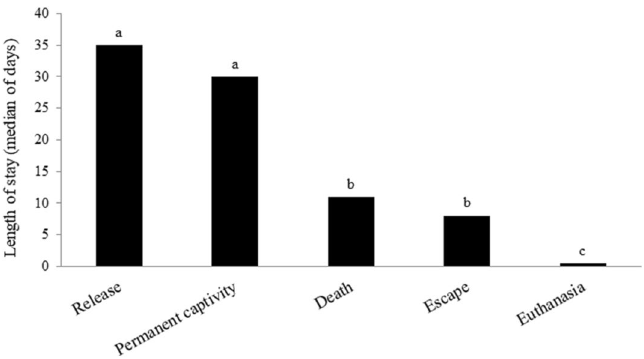
Figure 2. Comparison of the length of stay of common kestrels in rehabilitation centres depending on the outcome. a-c The values in columns with different superscript letters are significantly different ( P <